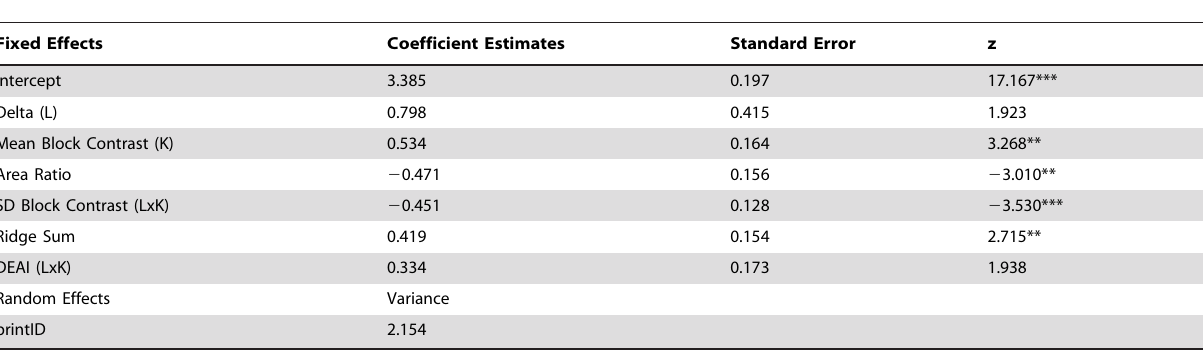
Table 2. Predictors for accuracy model.